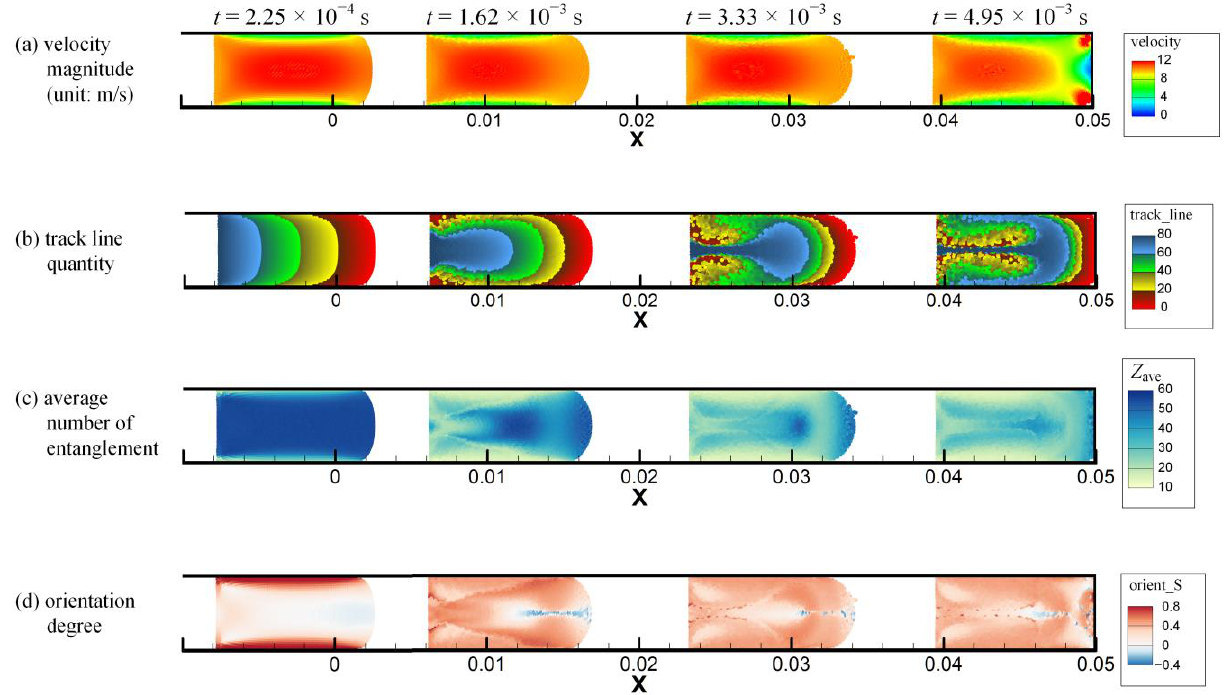
Figure 6. The multiscale simulation results of ( a ) velocity magnitude, ( b ) track line quantity, ( c ) average number of entanglements and ( d ) orientation degree distributions of injection molding in the simple long rectangular cavity at different times as indicated.